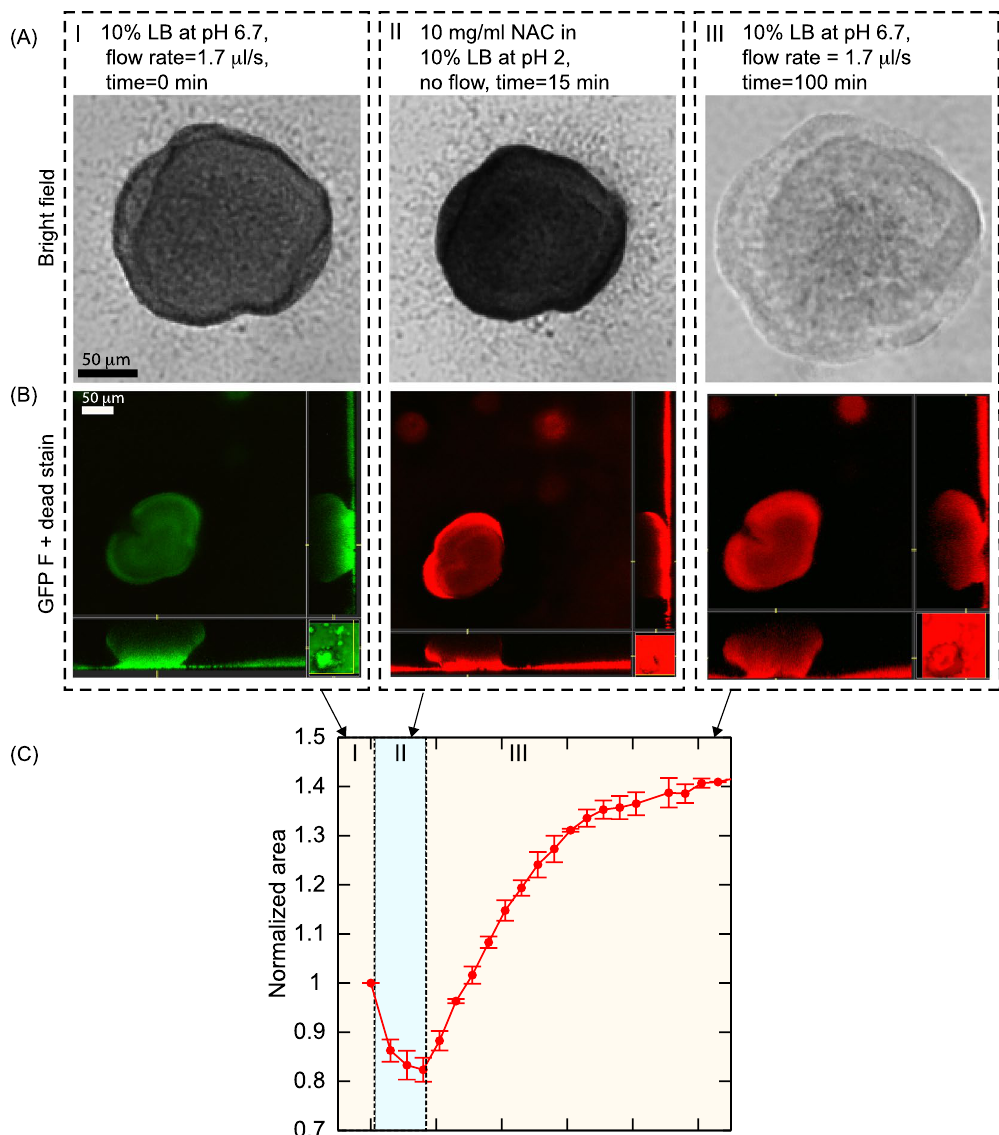
Figure 2. ( A ) Bright field images of a microcolony (I) in 10% LB at pH 6.7 just before treatment, (II) after treating with 10 mg/ml NAC where it shrinks in size, and (III) swells to a size larger than the original size when the pH was switched back to 6.7. Images show the density of the microcolonies also decreased considerably. ( B ) (I) Representative confocal image of microcolonies with bacteria expressing GFP. (II) Green and red channel immediately after the bacteria are treated with NAC. The red fluorescence from the dead stain indicates that the bacteria are dead. (III) Green and red channel after t = 100 min. ( C ) The change in size of microcolonies with time as obtained from the bright field images shows that the microcolonies shrank to 20% of the original size when treated with NAC and swelled to 40% of the original size when the pH was changed back to 6.7. Region I, II, and III correspond to before treatment, during treatment, and after treatment with NAC, respectively. The error bars are the standard deviation of the area obtained from four different microcolonies in the same flow